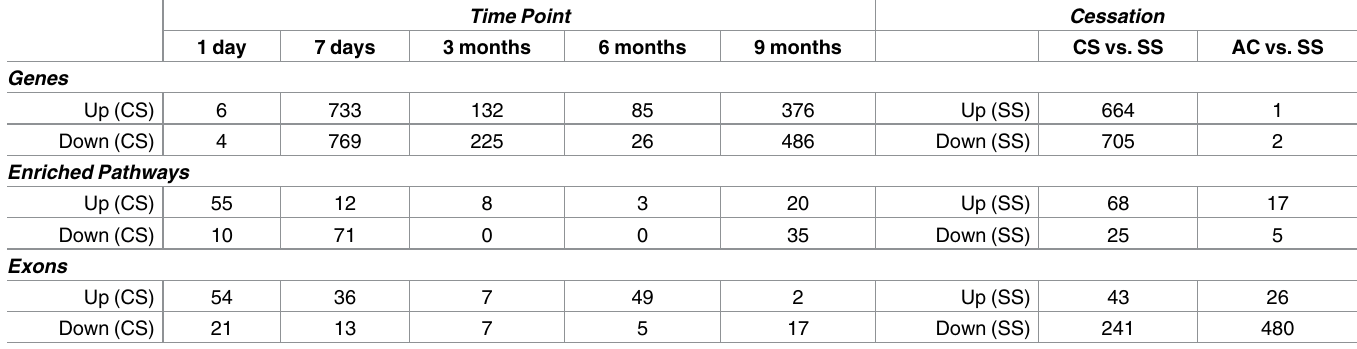
Table 1. Number of significantly differentially expressedgenes, perturbed pathways and differentially used exons identified between CS- and AC- exposed mice, and between pairwise comparisons with SS (cessation group, for stop smoking) mice (FDR (cid:20) 0.10, |FC| (cid:21) 1.5). Time